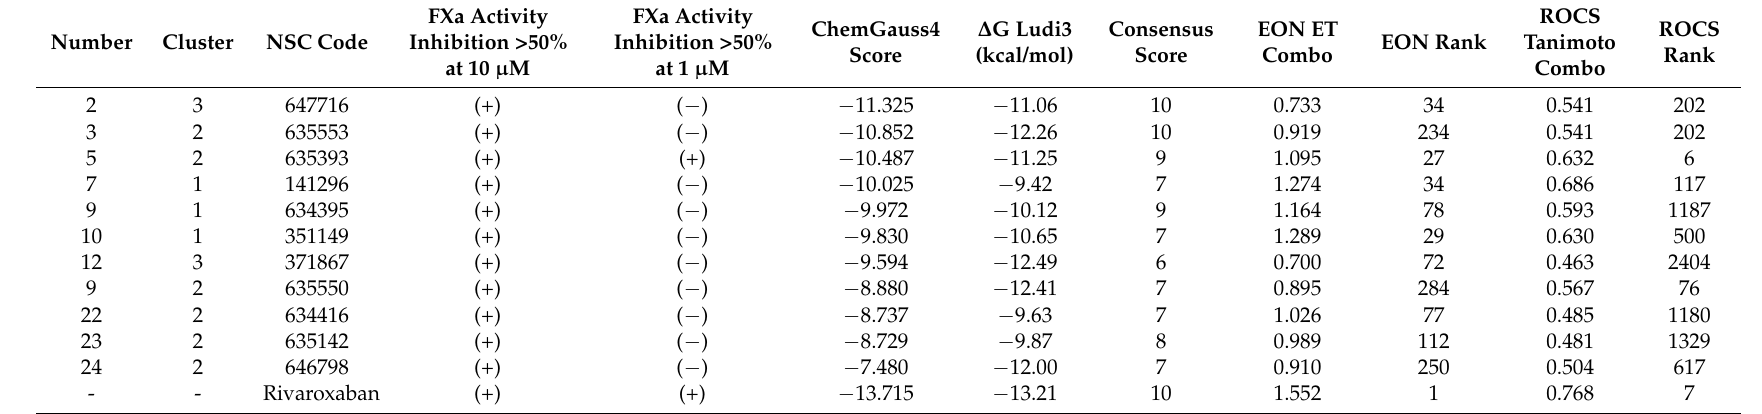
Table 2. Summary of biological activity, docking scores, binding energy estimation, and shape/electrostatic similarity scores for selected compounds used in this study. (See Table S1 for full